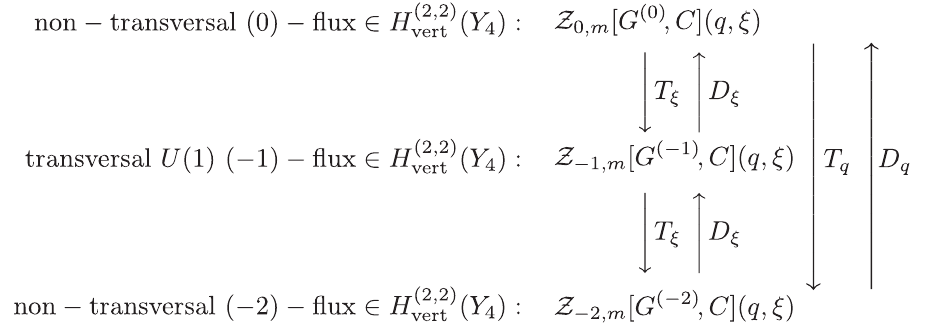
Figure 3 . Shown is how the holomorphic version of the algebra of derivatives (3.26) acts between the various flux partition functions. As discussed in [39], the partition function of modular weight w = − 1 , Z − 1 ,m , coincides with the refined elliptic genus of a chiral N = 1 supersymmetric theory in four dimensions with U(1) gauge group, while Z formally corresponds, for certain geometries, − 2 ,m to the elliptic genus of a six dimensional